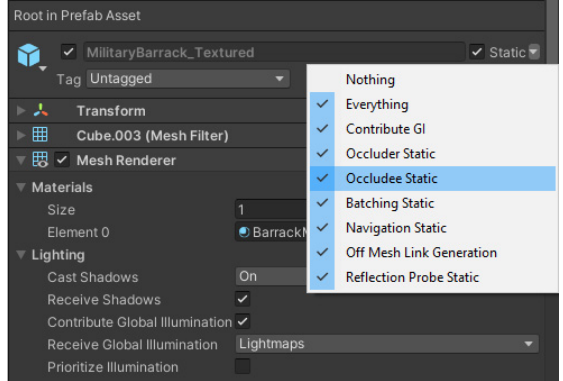
Figure 4. Set game object as occluder and occludee static.